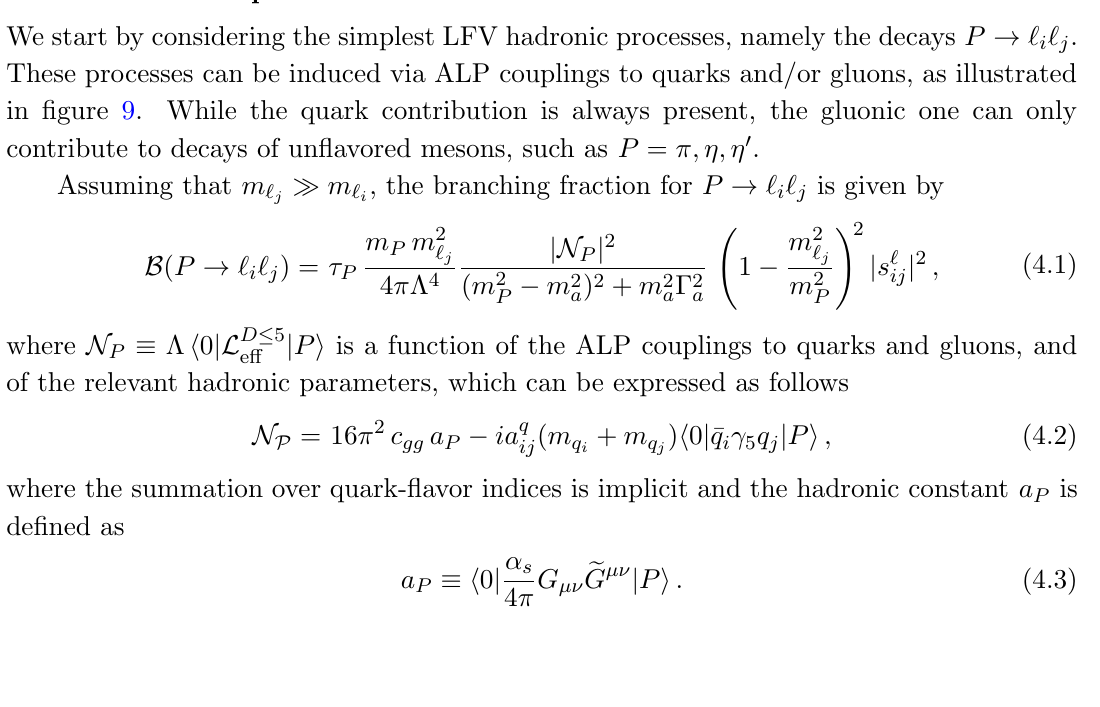
Figure 9 . Diagrams contributing to the processes P to quarks (left panel) and gluons (right panel), where P denotes a generic pseudoscalar meson. The latter diagram only contributes to processes involving light un(cid:13)avored